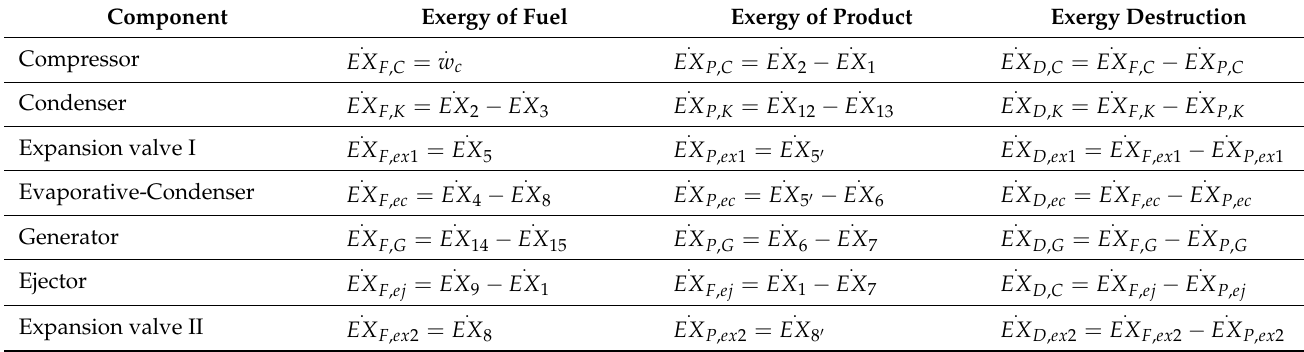
Table 3. Definition of fuel, production, and exergy destruction rates of the system components